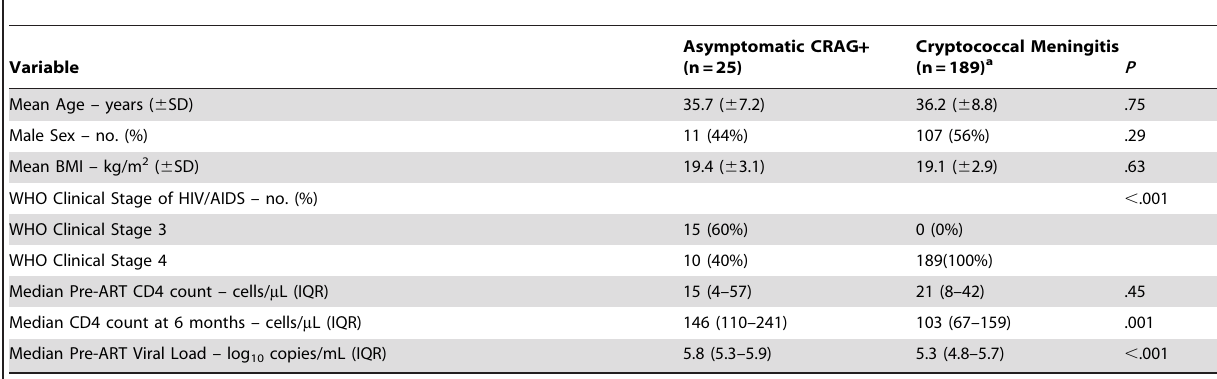
Table 1. Characteristics of persons presenting with asymptomatic, subclinical cryptococcal antigenemia (CRAG + ) and symptomatic cryptococcal